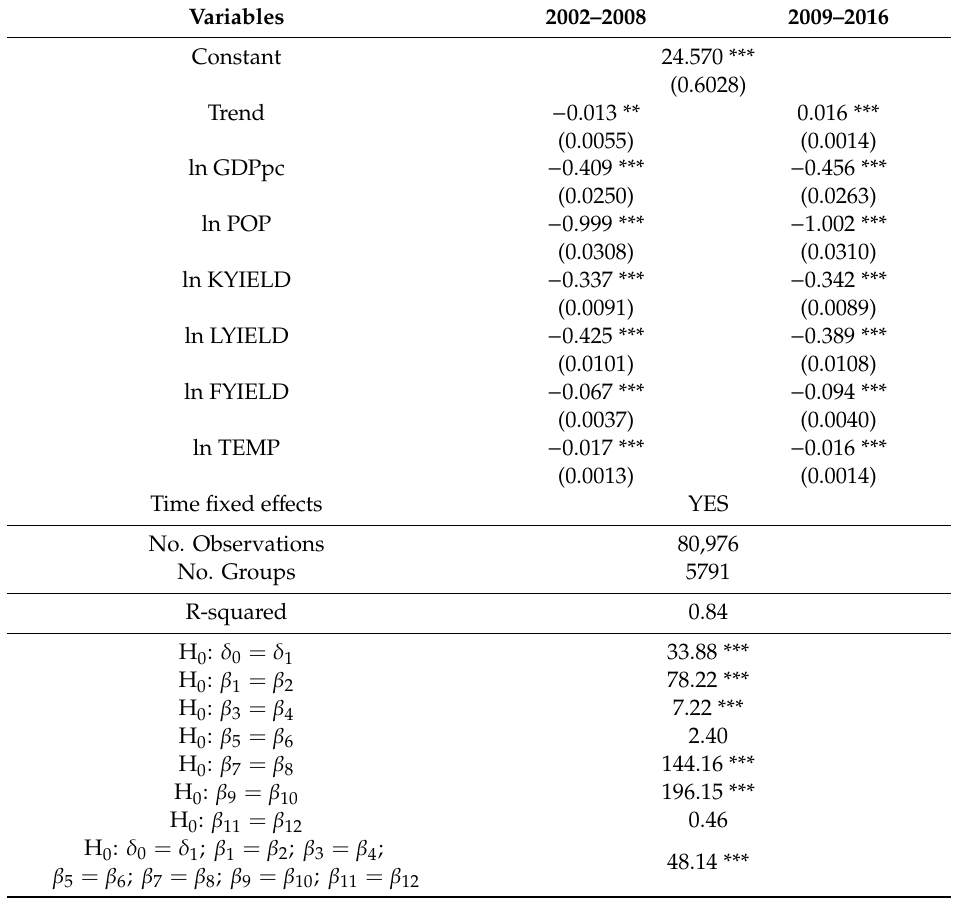
Table 3. Estimated results of model M4 before and after the year